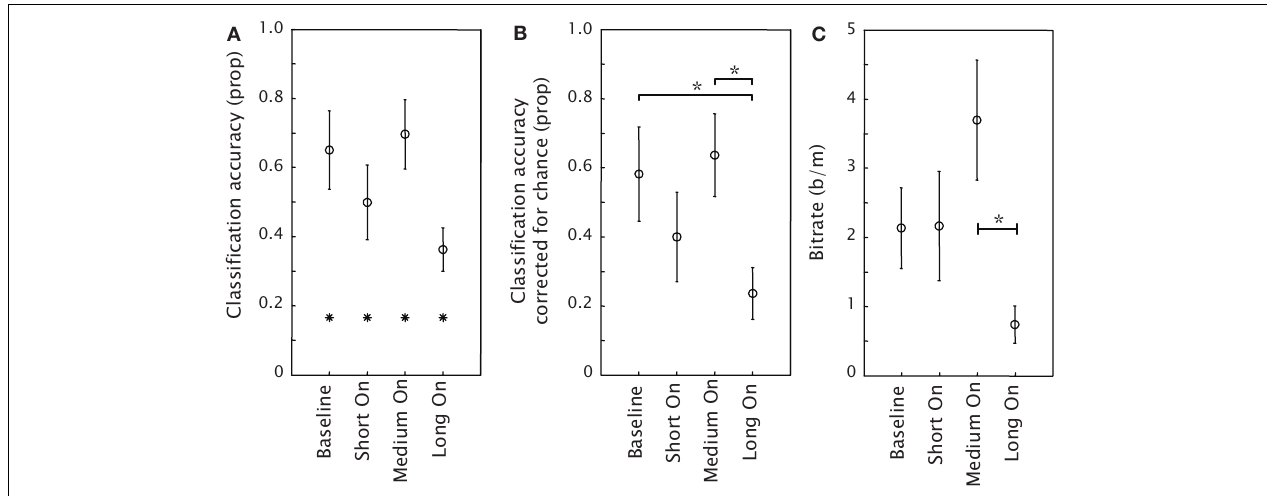
FIGURE 4 | Mean performance of the classifi cation model in the four conditions of Experiment 2 as expressed by classifi cation accuracy (A), classifi cation accuracy corrected for chance (B) and bitrate (C). The stars in (A) indicate chance performance. Error bars represent standard errors of the